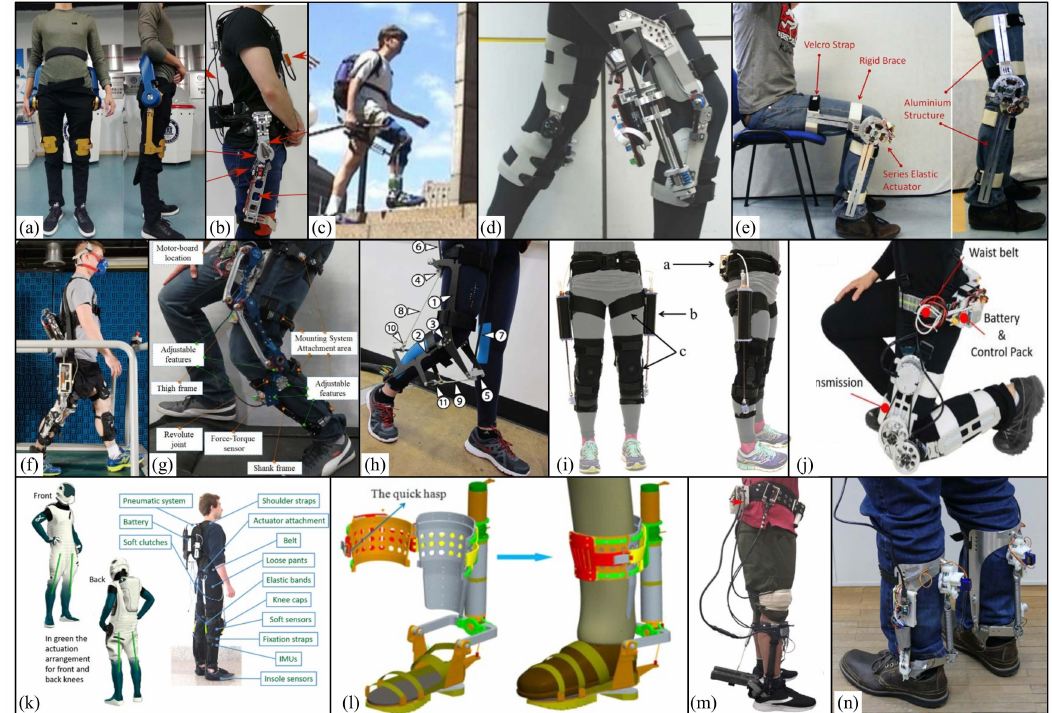
Figure 8. Single-joint quasi passive lower limb exoskeletons. ( a ) Chinese Academy of Science (CAS) [125]. ( b ) Slovenia, CQPSE [126]. ( c ) University of Michigan, RoboKnee [127]. ( d )